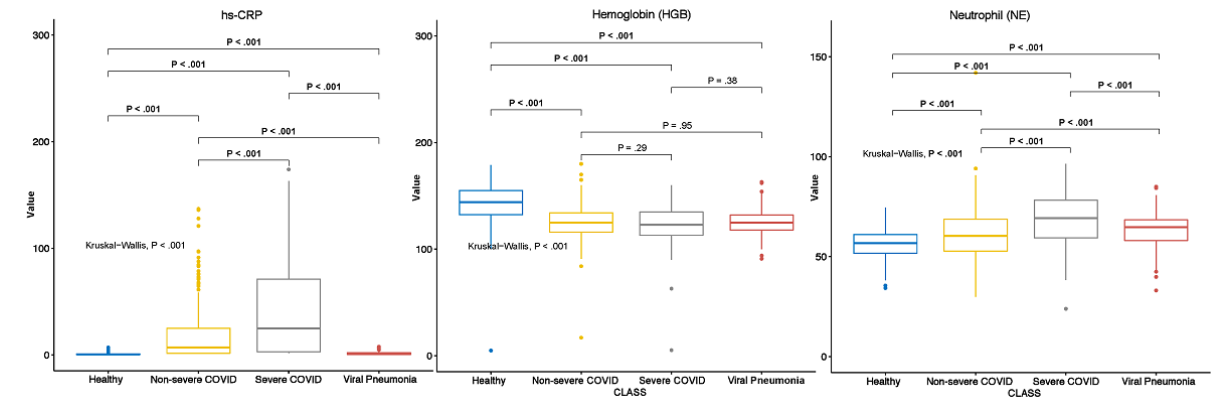
Figure 3. Multiple comparisons of the top differentiating lab testing features. hs-CRP: high-sensitivity C-reactive protein.